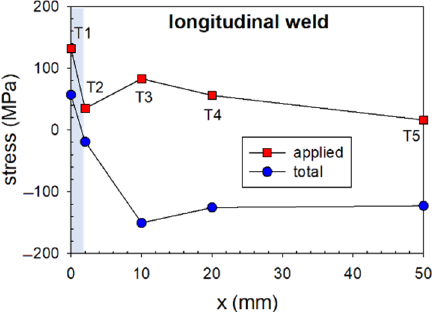
Figure 12. Applied stress distribution and the total stress (sum of the applied and residual stresses) at pressure 16 bar as a function of the distance from the weld axis. The blue area denotes the position of the corresponding